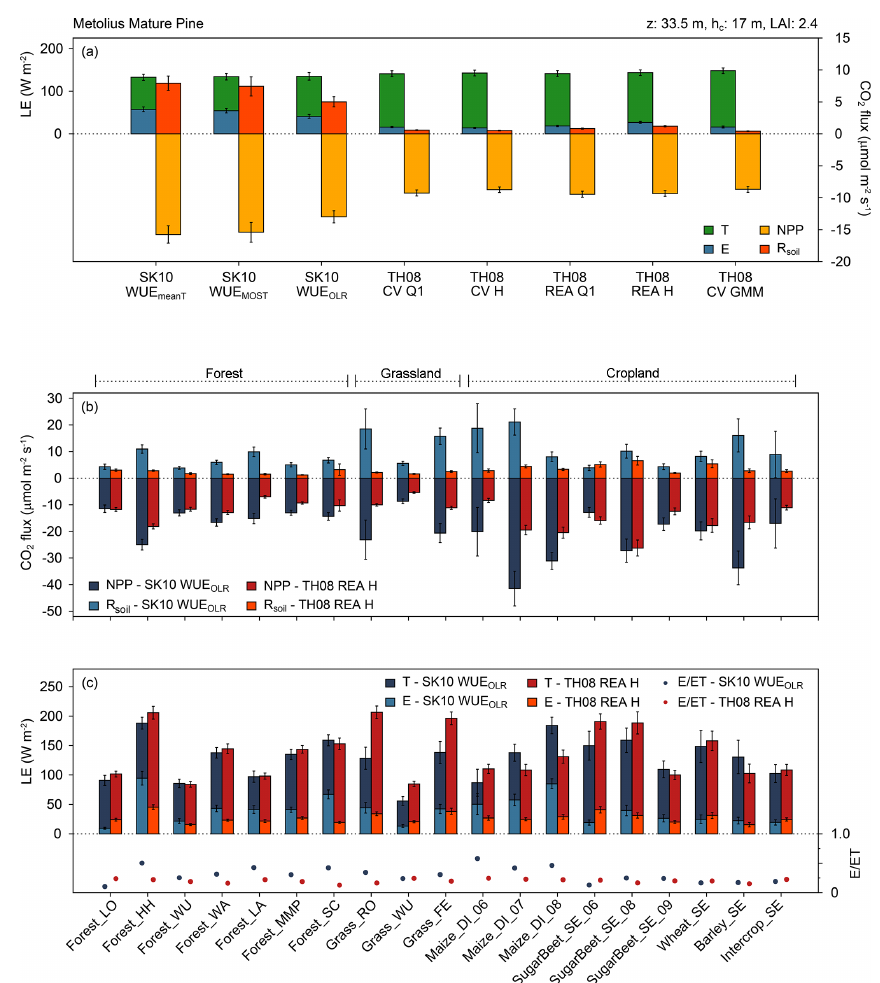
Figure 5. Averages of source partitioning results for the following: (a) H 2 O and CO 2 fluxes for the Metolius Mature Pine study site (forest) in the US and for all method versions; (b) CO 2 fluxes for all study sites and for the approaches after Scanlon and Kustas (2010; SK10) with WUE OLR and after Thomas et al. (2008; TH08) with REA H; and (c) H 2 O fluxes and the partitioning fraction E / ET for all study sites and for the approaches SK10 WUE OLR and TH08 REA H (see text for description; LE: latent heat flux; E : evaporation; NPP: net primary production; R soil : soil respiration; z : measurement height; h c : canopy height; LAI: leaf area index). Error bars indicate the 95% confidence intervals of the mean values. For each study site, net fluxes (evapotranspiration and net ecosystem exchange) differ between method versions because each method version found a different number of partitioning solutions, and thus the averages were taken from different subsets of the original